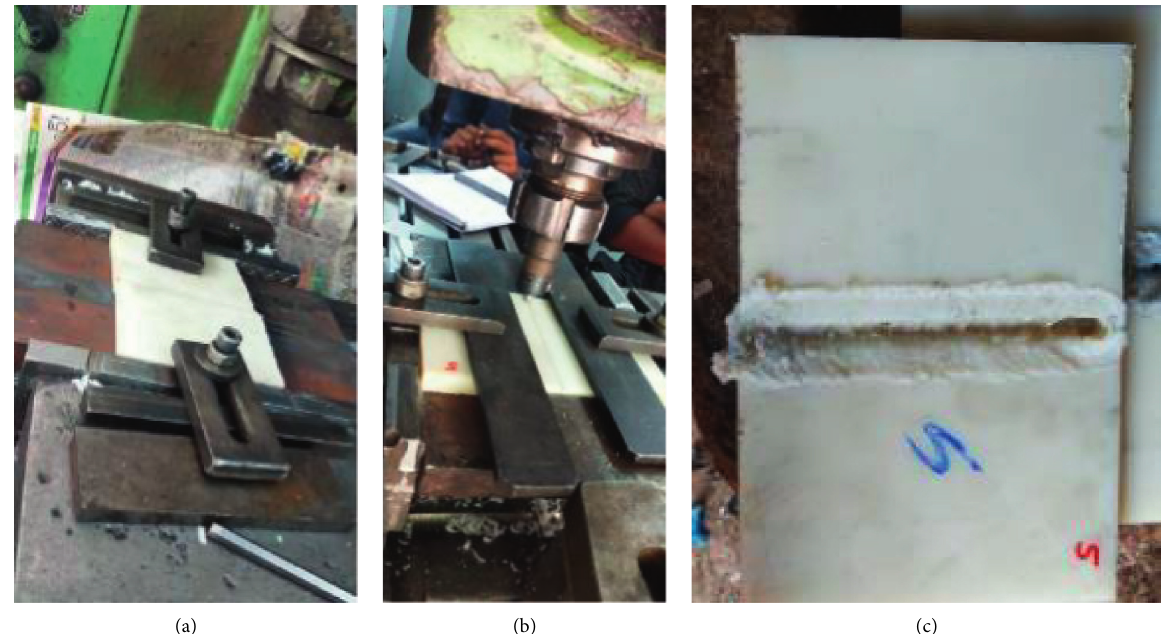
Figure 5: (a) Workpiece clamping. (b) FSW process. (c) Final specimen joint.